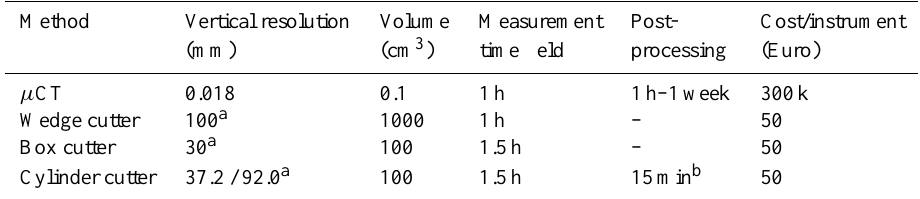
Table 1. Vertical resolution and measurement volume of the different methods. Measurement time in the field is per meter of snow depth and includes digging a snow pit.